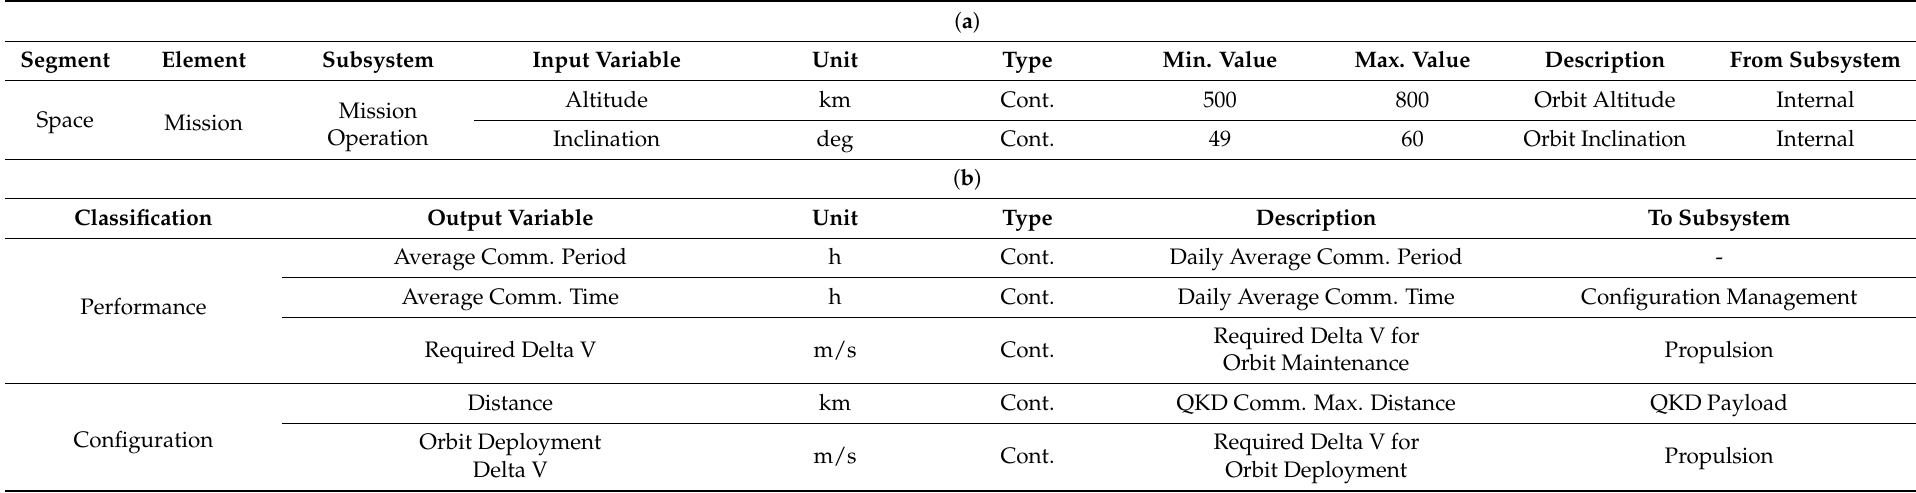
Table 5. Interface control document for mission